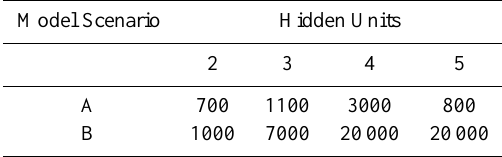
Table 2. Epochs for preferred NNRFs based on validation